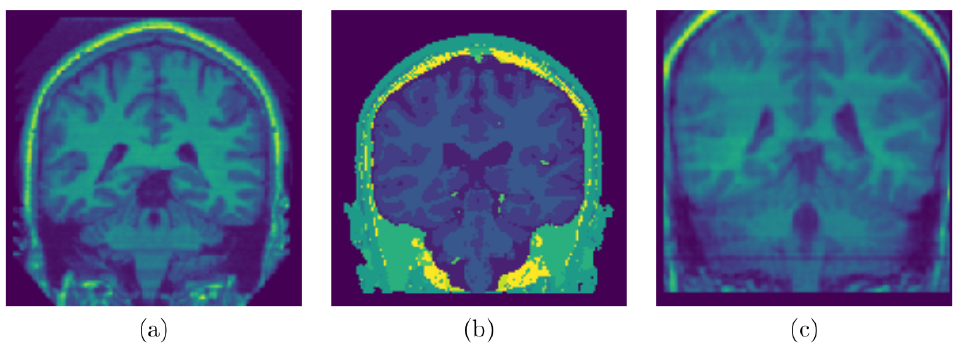
Figure 1. Sampled Slices: ( a ) Sampled slice coronal section from a 3D MRI volume OASIS data set, ( b ) Sampled slice coronal section from a 3D MRI volume BW data set, ( c ) Sampled slice coronal section from a 3D MRI volume IBSR data set. Notice the differences and the quality of data sets.